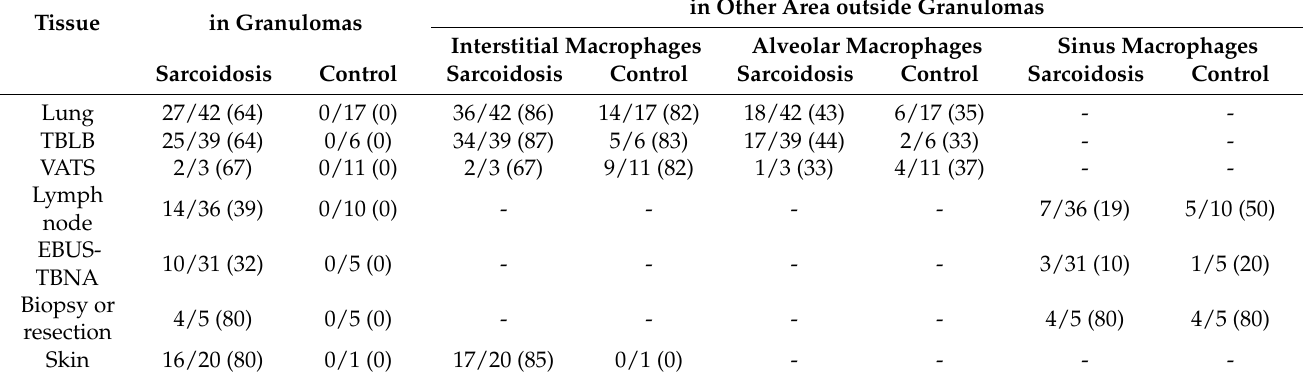
Table 3. Detection frequency of P. acnes in tissues by localization in sarcoidosis patients and control patients with other granulomatous